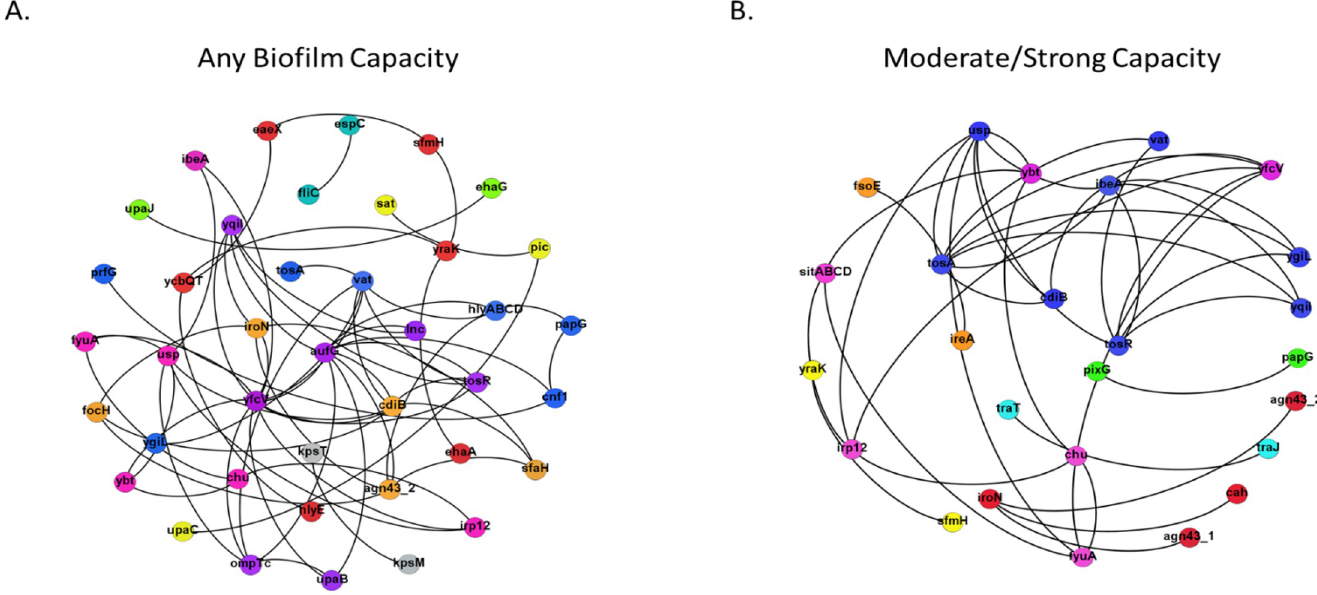
Fig 4. Co-occurrence networks of the unique virulence gene relationships among different levels of biofilm production. (A) Virulence co-occurrence network of unique gene relationships among isolates forming any type of biofilm. Only significant co-occurrences with a Spearman’s rho � 0.6 are shown. (B) Virulence co- occurrence network of unique gene relationships among isolates forming moderate/strong biofilms. Only significant co-occurrences with a Spearman’s rho � 0.6 are shown. Nodes are color coded to represent virulotype clusters based on community partitioning analysis.